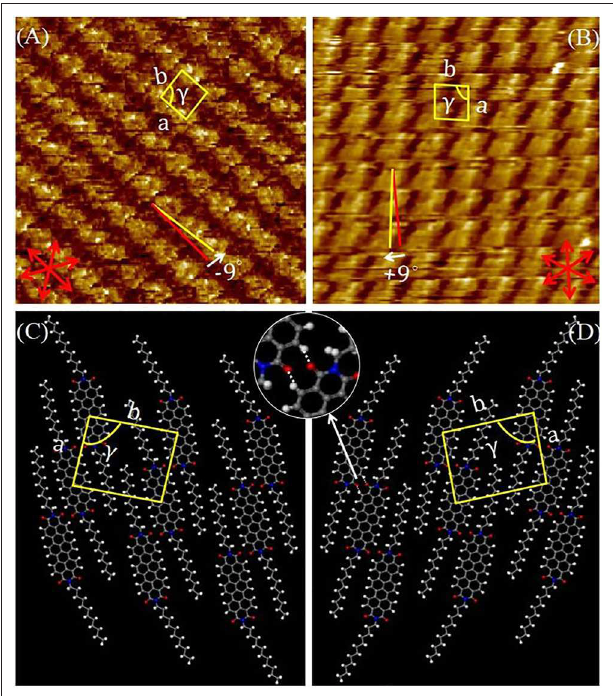
FIGURE 5 | Large-scale STM images (60 × 60 nm 2 ) of DUO-TDI at the (A) 1-Octanoic acid-HOPG interface and (B) 1-Phenyloctane-HOPG interface. Imaging conditions: (A) I set = 70pA, V bias = − 750mV; (B) I set = 75pA, V bias = − 750mV. One DUO-TDI is enclosed by a white oval in each image, and the inset indicates the magnified image for clarity. The yellow arrow points to the structure direction of the strip.